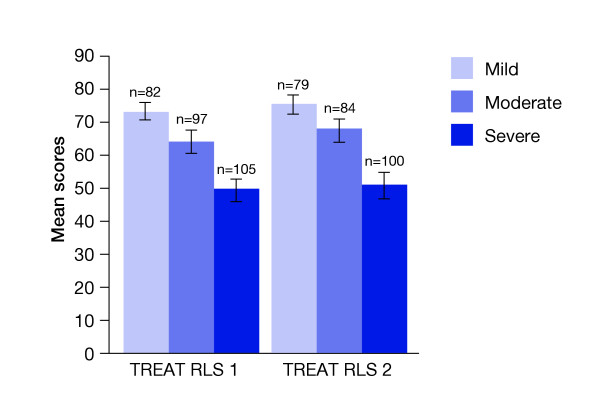
Known groups validity. RLSQoL overall life impact scores by mild, moderate and severe sleep problems. p < 0.0001 for comparisons of RLSQoL overall life impact scores among sleep problems severity groups defined by taking tertile scores for the Sleep Problems Index II in TREAT RLS 1 and 2 (Kruskall-Wallis test). RLSQoL = RLS Quality of Life questionnaire.